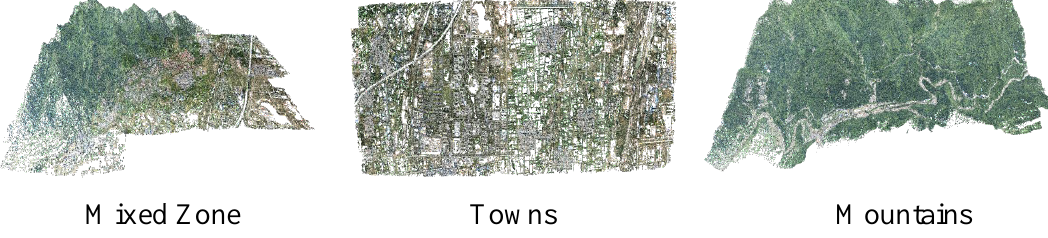
Figure 7. Experimental results of three datasets, from left to right: mixed zone, towns, and mountains.